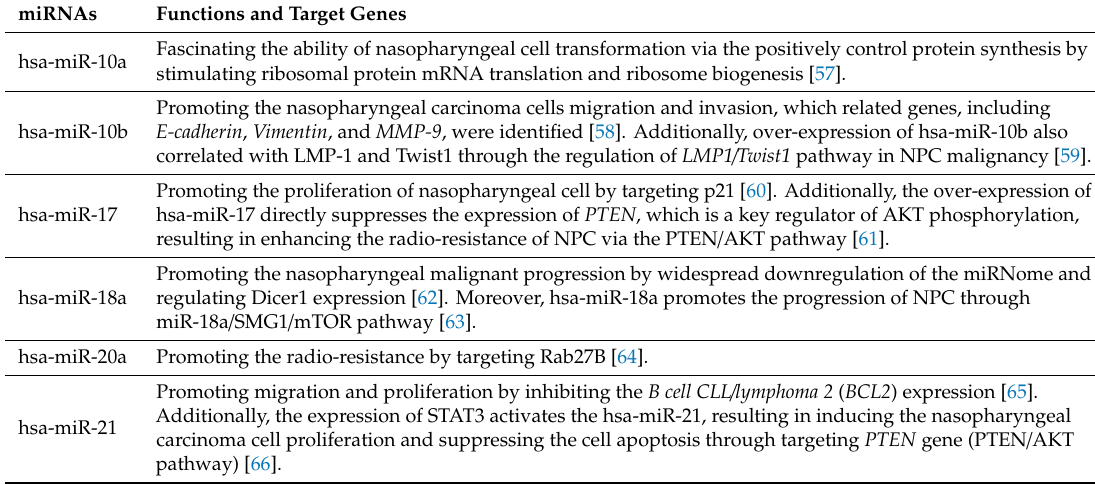
Table 2. List of miRNAs as oncogenes in